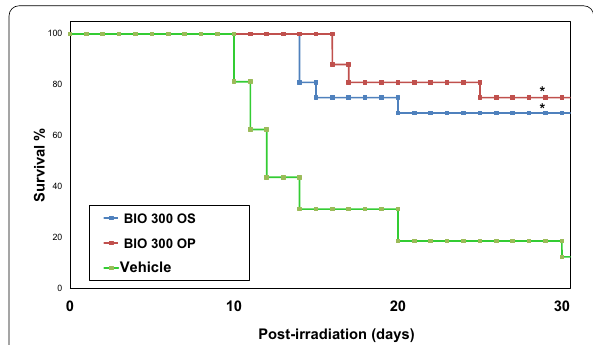
Fig. 2 Radioprotective efficacy of BIO 300 formulations. Three groups of mice (n 16) were administered either with BIO 300 OS, = BIO 300 OP, or the vehicle po twice daily for six consecutive days prior to irradiation with 9.2 Gy. Survival was monitored for 30 days post-irradiation. *Indicates a significant difference compared to vehicle control (p < .05, log-rank test)